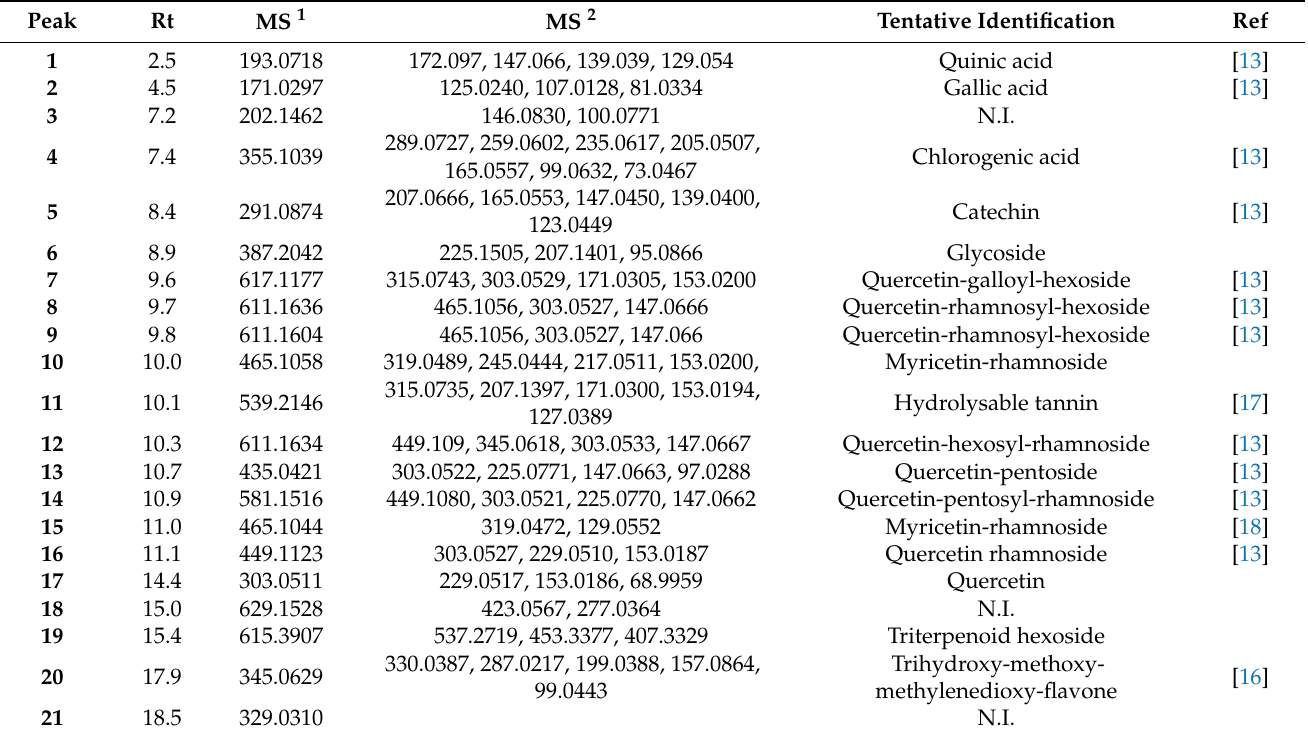
Table 2. Characterization of the compounds identified by